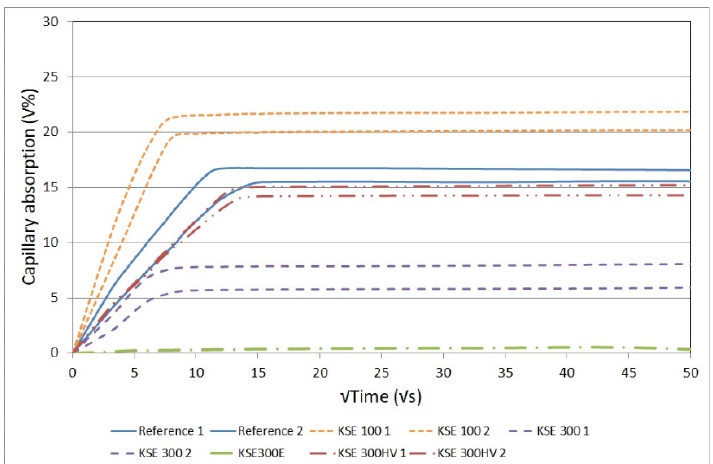
Figure 6. Capillary water absorption in untreated and consolidated medium-grained limestone from Sóskút (SM).